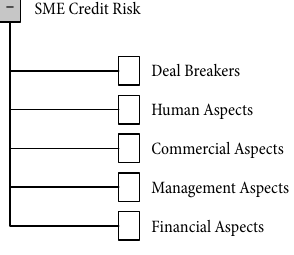
Fig. 3. Tree of points of